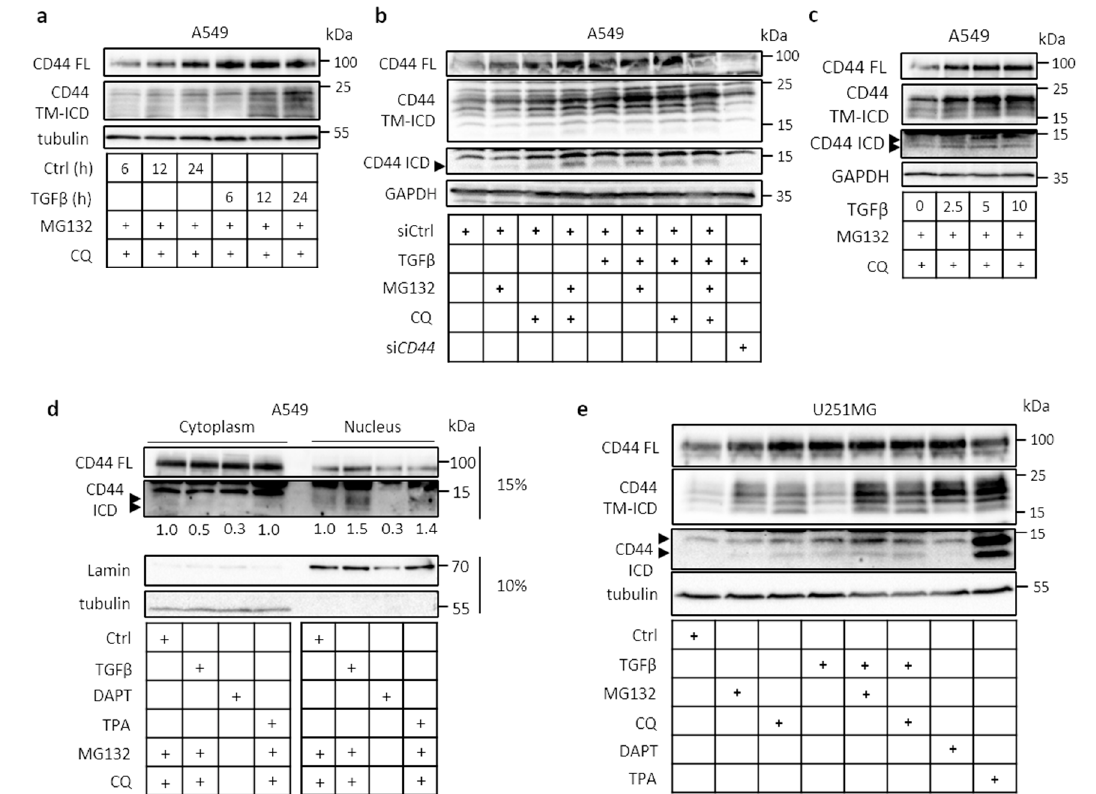
Figure 1. Transforming growth factor β (TGF β ) induces ectodomain and intramembranous cleavage of CD44 in a dose- and time-dependent manners. ( a,b ) Immunoblot analysis of full-length (FL) and cleavage products (transmembrane and intracellular domain (TM-ICD) and ICD) of CD44 in A549 cells after treatment or no treatment with TGF β (5 ng/mL) for the indicated time periods; knockdown of CD44 by siRNA was performed to confirm the specificity of observed bands ( b ). ( c ) Immunoblotting of FL CD44, as well as the TM-ICD and ICD of CD44 after 24 h of treatment with different concentrations of TGF β . ( d ), A549 cells treated or not with TGF β (5 ng/ml), DAPT (40 µ M), MG132 and CQ for 24 h, or TPA (80 nM) for 1 h, were subjected to nuclear/cytoplasmic fractionation and subjected to SDS gel electrophoresis in 15% or 10% polyacrylamide gels, followed by immunoblotting for FL, ICD of CD44, lamin, and tubulin. Quantification of CD44-ICD bands was performed via ImageJ after normalizing to CD44 FL ( e ), Immunoblot analysis of FL CD44, as well as the TM-ICD and ICD of CD44 in U251MG cells treated or not treated with TGF β for 24 h, or 12-O-tetradecanoylphorbol-13-acetate (TPA) (80 nM) for 1 h. The cultures were treated with the γ -secretase inhibitor DAPT (40 µ M)), the proteasomal inhibitor MG132, and the lysosomal inhibitor chloroquine (CQ) for 24 h; tubulin or glyceraldehyde 3-phosphate dehydrogenase (GAPDH) were used as loading controls in the same immunoblots. Arrowheads indicate CD44 ICD-like